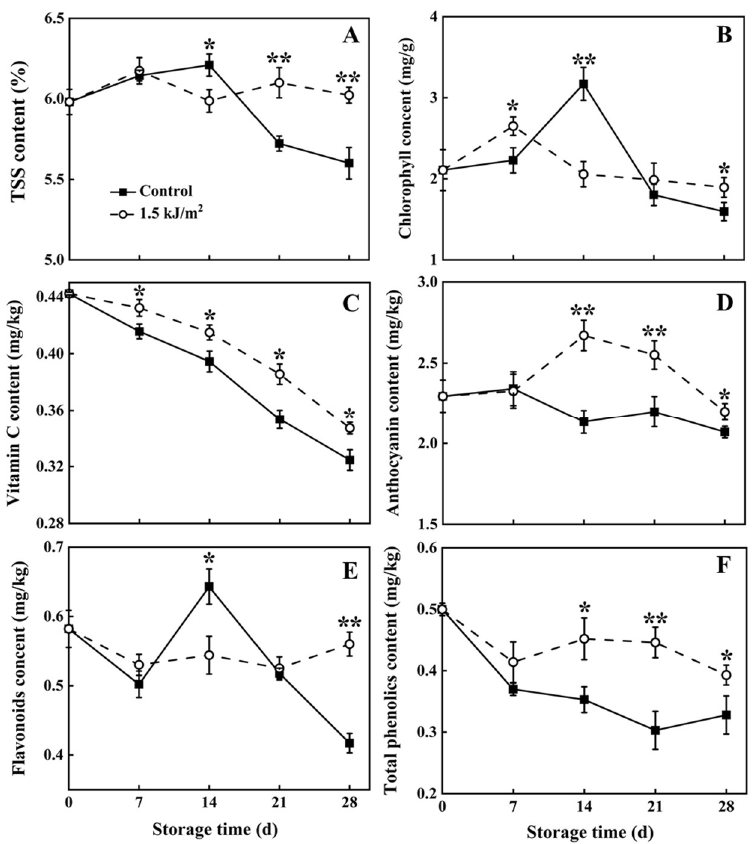
Figure 2. TSS ( A ), chlorophyll ( B ), vitamin C ( C ), flavonoids content ( D ), anthocyanin ( E ) and total phenolic content ( F ) of pepino fruit treated with dark (control) and UV-C during storage. Chlorophyll, vitamin C, and total phenolic content were measured in pulp tissue; flavonoid and anthocyanin content were measured in peel tissues. Asterisk (*) indicates a significant difference between the control and UV-C treatment groups at p < 0.05. Whereas a double asterisk (**) indicates significance at p < 0.01.